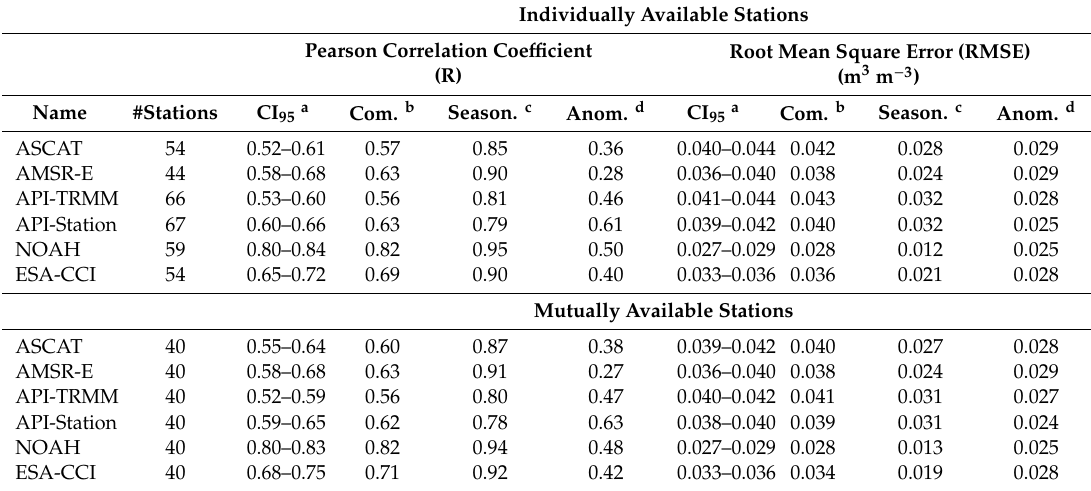
Table 6. Statistics of soil moisture products over individually and mutually available